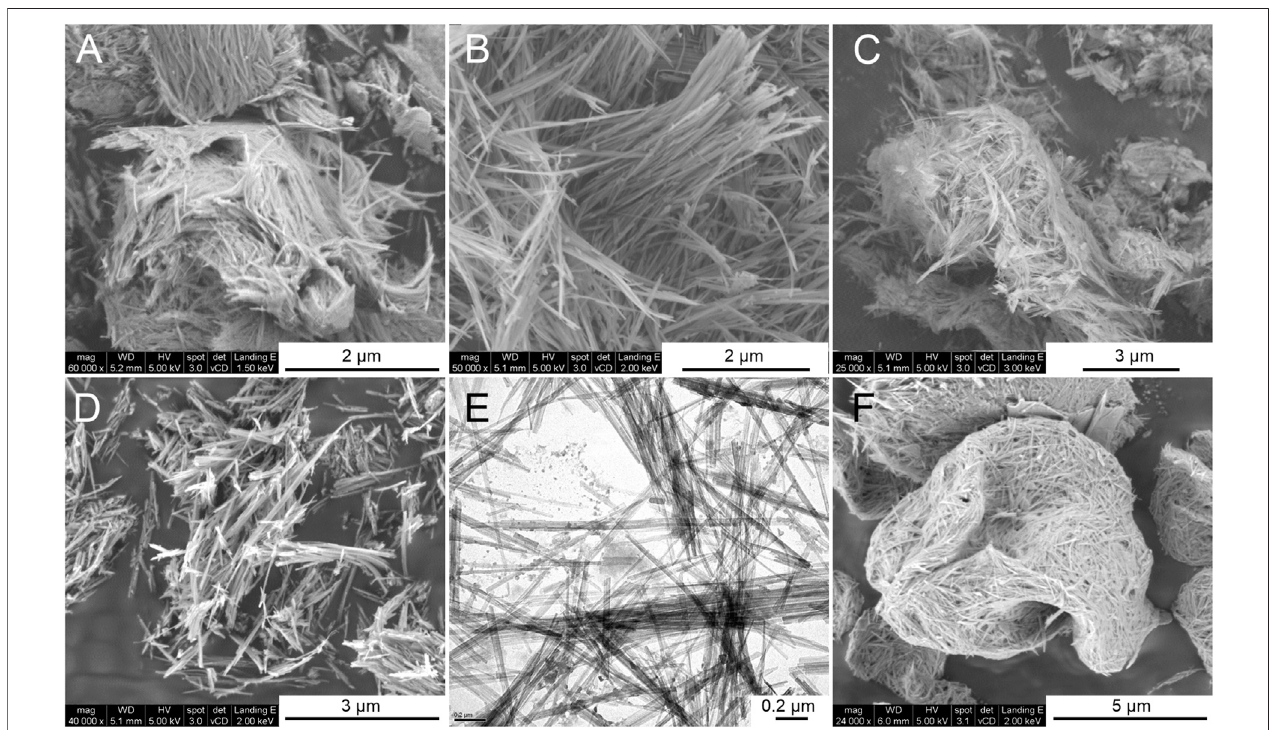
FIGURE4| FE-SEMimagesof (A) starting30 – 60granularsepiolite,andsepiolitexerogelsobtainedby (B) freeze-drying, (C) centrifugationandair-dried, (D) drying by evaporation at 60 ° C, and (F) spray-drying. The image (E) corresponds to TEM micrograph of xerogel obtained by evaporation at 60 ° C.